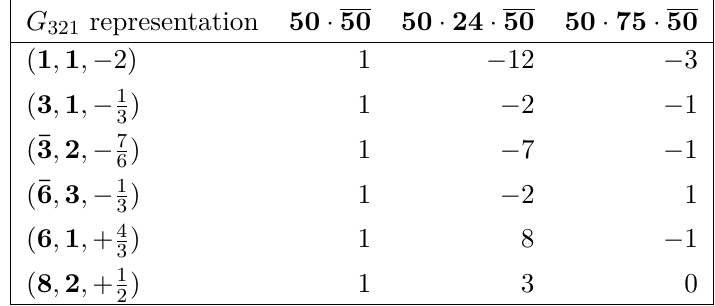
Table 6 . Clebsch factors (up to an overall VEV normalization factor) for all different SM repre- sentations in the 50 (or 50 ) of SU(5) in the three different operators generating their masses.